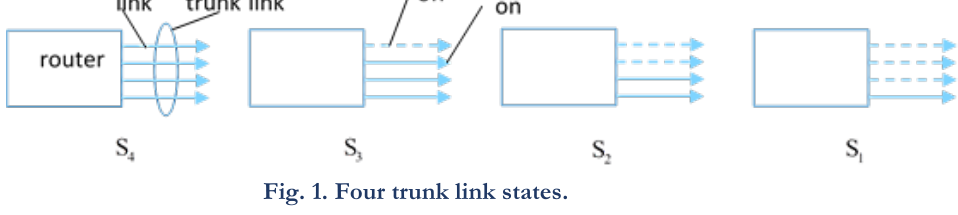
Fig. 1. Four trunk link states.